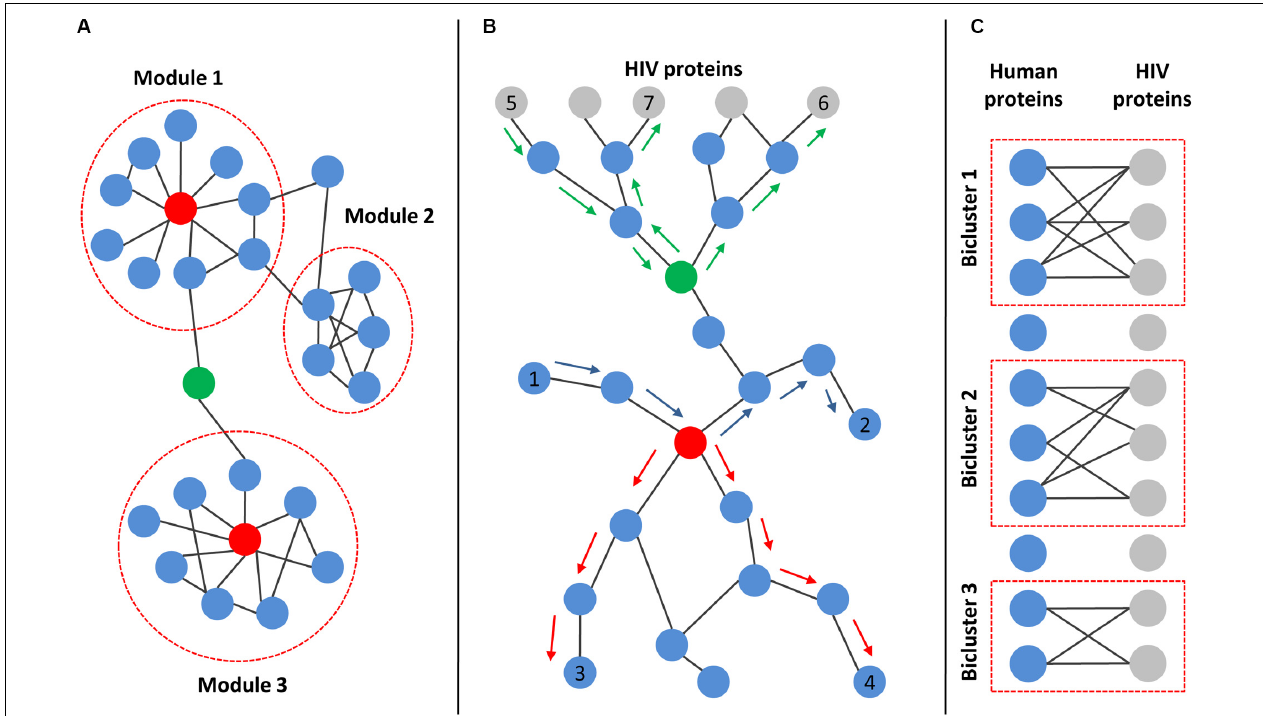
FIGURE 3 | Main topological characteristics of human and HIV–human protein–protein interaction networks. (A) Example of a network with modular structures. Modules are dense communities of nodes that are highly interconnected but weakly connected to other nodes in the network. Red nodes represent “hubs,” which are proteins with a high number of interactions. Green node is an example of “bottleneck,” which exclusively connects distinct modules. (B) Principle of centralities calculation. Both closeness and betweenness centralities rely on the shortest paths between pairs of nodes in the network. The closeness centrality is the average length of the shortest paths between the protein and all the other proteins in the network (the shortest paths between red-colored node and nodes 3 and 4 are marked by red arrows). The betweenness centrality quantifies the number of times a protein acts as a bridge along the shortest path between two other proteins in the network (the shortest path between node 1 and node 2 passing through the red-colored node is marked by blue arrows). If the network includes both interactions between human proteins (blue nodes) as well as interactions between human and HIV proteins (gray nodes), then the modified betweenness centrality can be calculated. It reflects the number of times a human protein acts as a bridge along the shortest path between two HIV proteins (the shortest paths between node 5 and node 6 or node 7 passing through green-colored node are marked by green arrows). (C) Illustration of bipartite graph and biclusters. The bipartite graph contains two types of nodes (corresponding to HIV and human proteins) and edges connecting only nodes of different types, but not the same type. The corresponding data can be used to identify biclusters, which contain human proteins that interact with a common set of HIV